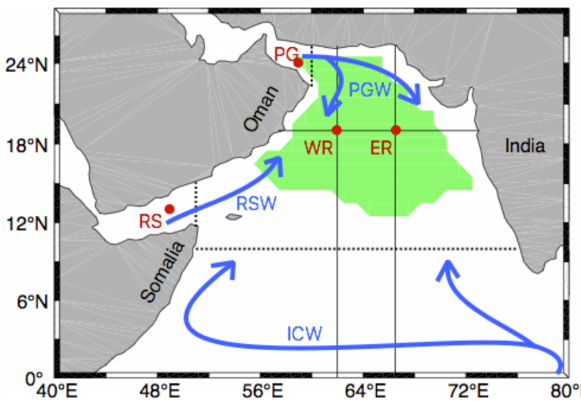
Figure 1. Schematic pathways of the three major intermediate source water masses in the northwest Indian Ocean marked in blue: Indian Central Water (ICW), Red Sea Water (RSW), and Persian Gulf Water (PGW). The green patch sketches the location of the Arabian Sea OMZ (ASOMZ) defined by an oxygen concentration less than 10µmolkg − 1 . Locations of four particle release points (western basin – WR, eastern basin – ER, Persian Gulf – PG, Red Sea – RS) are shown as red dots. Black solid lines indicate the sec- tions shown in Fig. 2. Sections that need to be crossed by the La- grangian particles to define the source regions for the ICW, RSW, and PGW are marked as black dashed